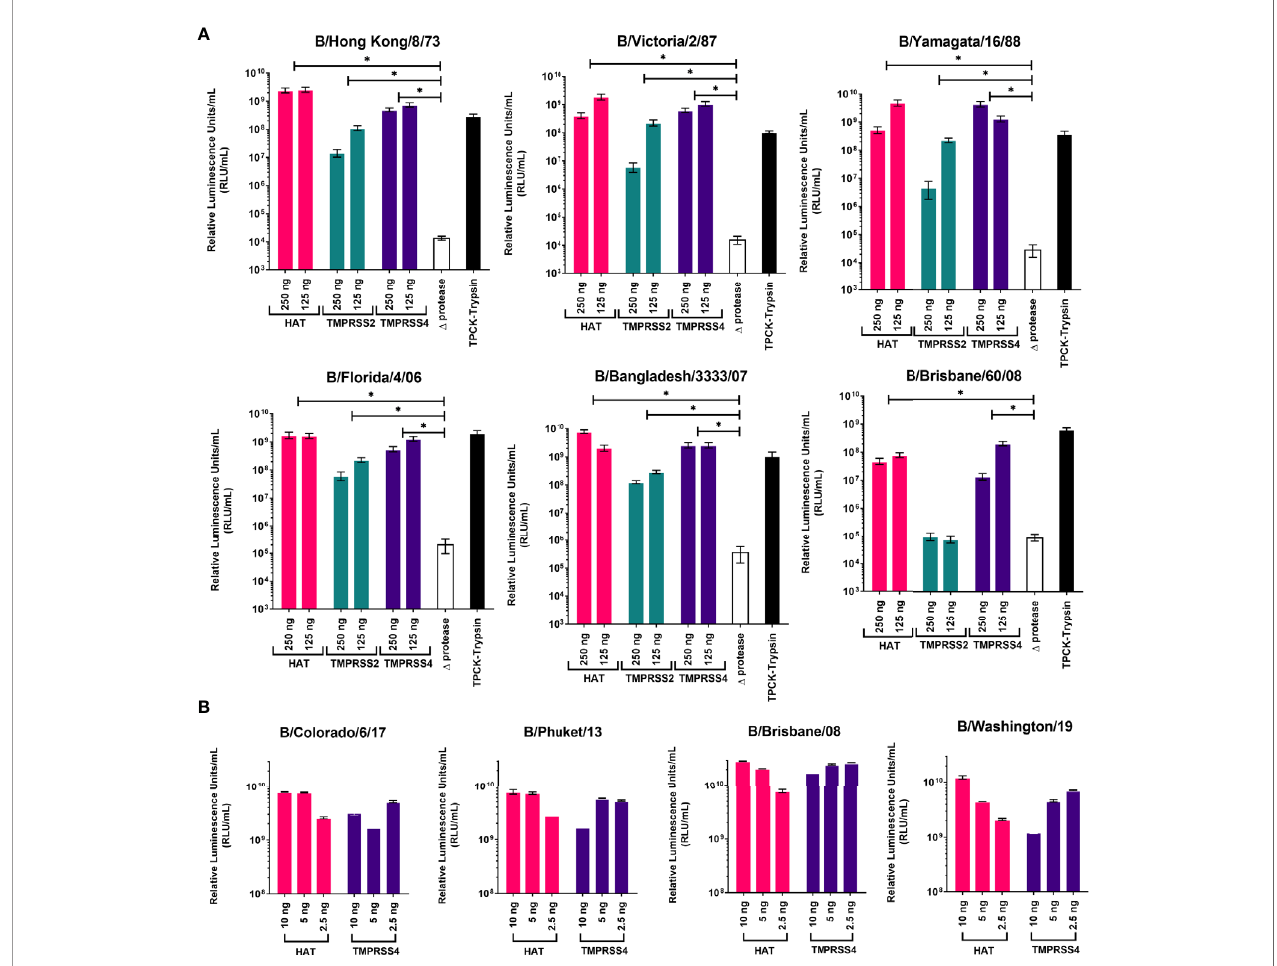
FIGURE 2 | Production of in fl uenza B pseudotypes employing different proteases. Various quantities of proteases were co-transfected with gag-pol packaging construct, fi re fl y luciferase and in fl uenza B HA-encoding plasmids in pI.18 (A) or pEVAC (B) . (A) For transfection employing pI.18 HA plasmids, HAT, TMPRSS2 and TMPRSS4 were used in 250 and 125 ng quantities. Pseudotypes produced in the absence of protease ( D protease) and those activated post-transfection and pre- titration with TPCK-Trypsin are also included. Plates were read using the Bright-Glo ™ assay system (Promega) and GloMax Multi detection system luminometer (Promega). (B) For transfection employing pEVAC plasmids, only HAT and TMPRSS4 proteases in the range of 2.5 ng-10 ng were used. Titration plates were then read using the GloMax ® Navigator (ProMega) using the Promega GloMax ® Luminescence Quick-Read protocol. For both (A, B) , pseudotype virus titers are expressed in relative luminescence units/mL (RLU/mL). Signi fi cant differences between titers obtained for each PV grouped into protease used and D protease are shown via brackets (*p=<0.05). Error bars show mean and standard deviation of four